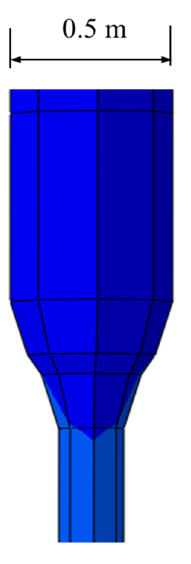
Figure 7. Pile tip optimization .